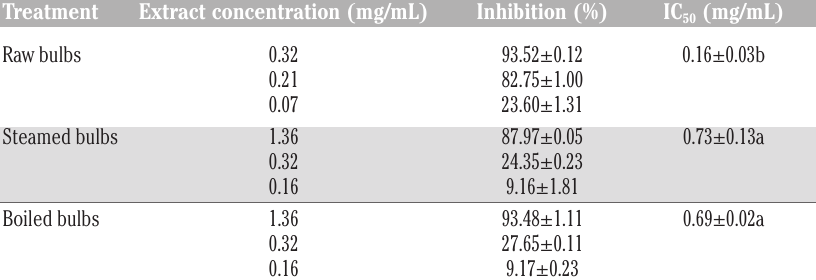
Table 4. α -amylase inhibitory activity of extracts of raw and cooked lampascioni ( Muscari comosum ). Treatment